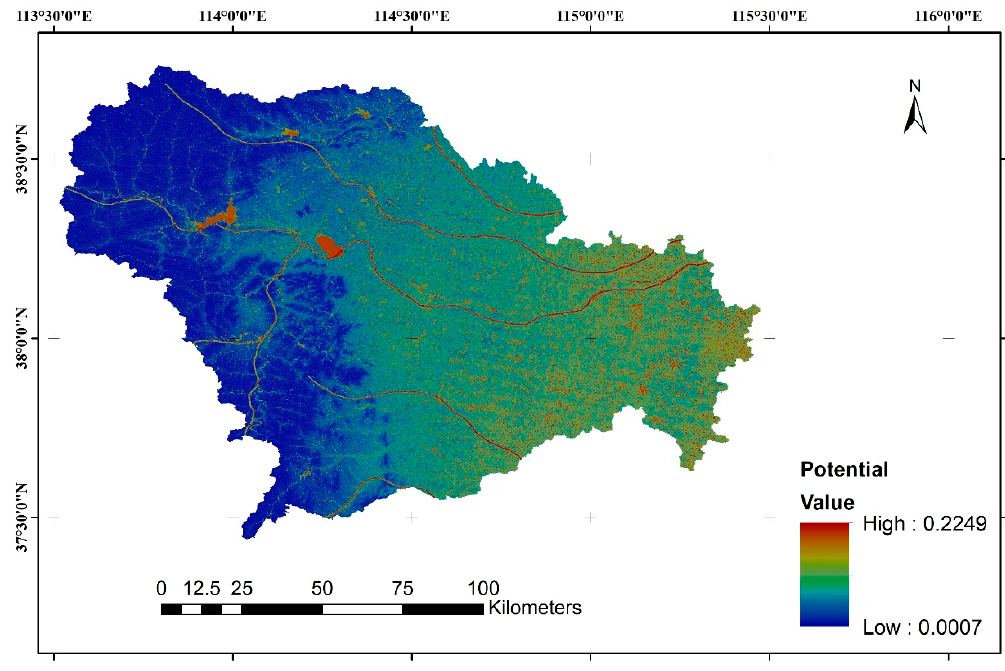
Figure 5. Flood disaster potential factor map of Shijiazhuang.